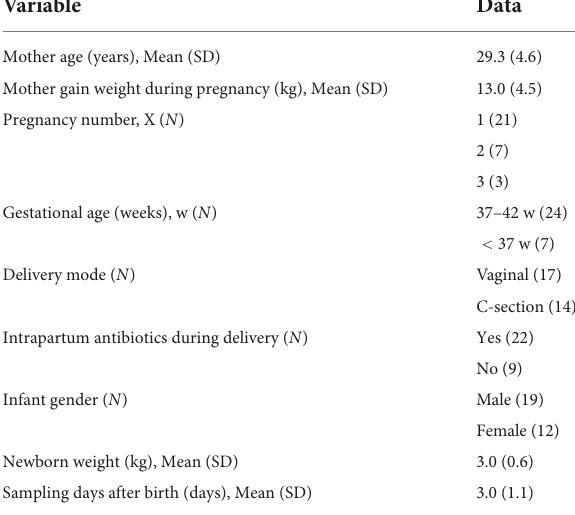
TABLE 1 Average demographics of the participants. Variable